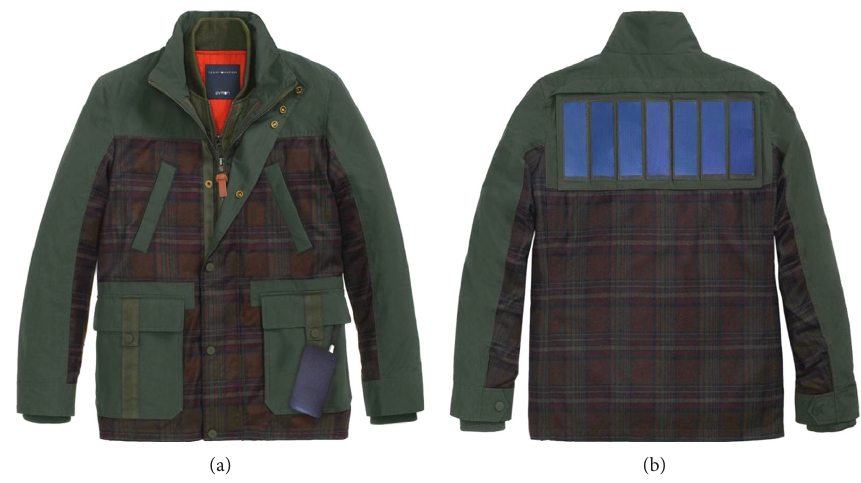
Figure 9: An example of a jacket with removable solar panels (Courtesy of http://www.pvilion.com)